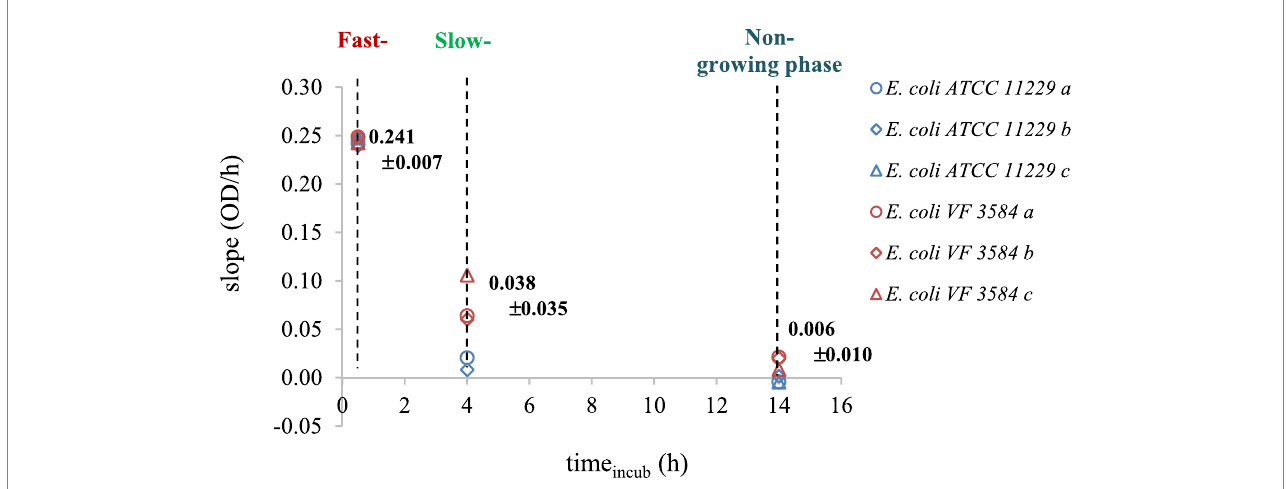
FIGURE 2 Physiological states of E. coli ATCC 11229 (blue markers) and E. coli VF 3584 (red markers) were quantified by the slopes of the OD-curves. Measurements were carried out in triplicates noted by a , b , and c letters.